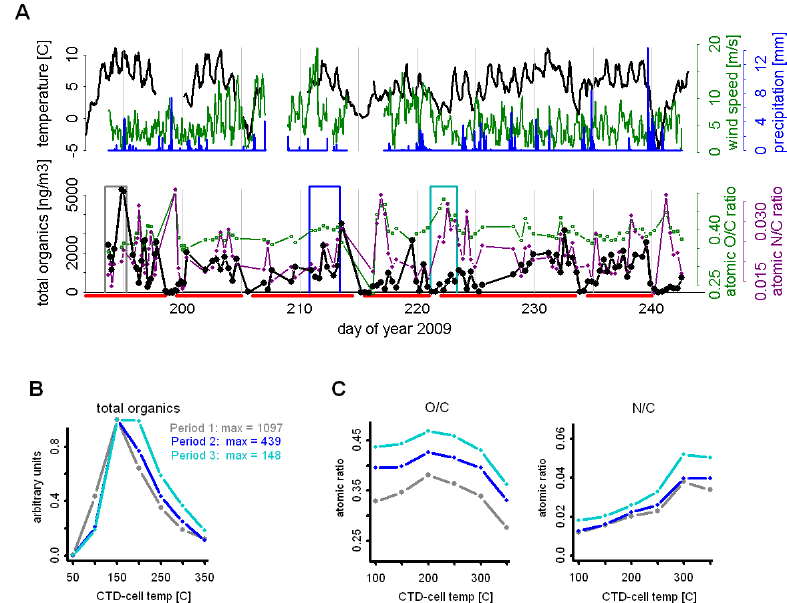
Figure 5. Panel A shows the sum of all organic compounds, the atomic ratios O/C and N/C, and some meteorological data throughout the campaign. Panel B shows a thermogram of the total detected organic material for 3 selected periods which are marked in Panel A. The data are normalized to the highest concentration the value (in ng m -3 ) of which is given in the legend. Panel C gives the thermogram information for the ratios O/C and N/C for the same three periods.